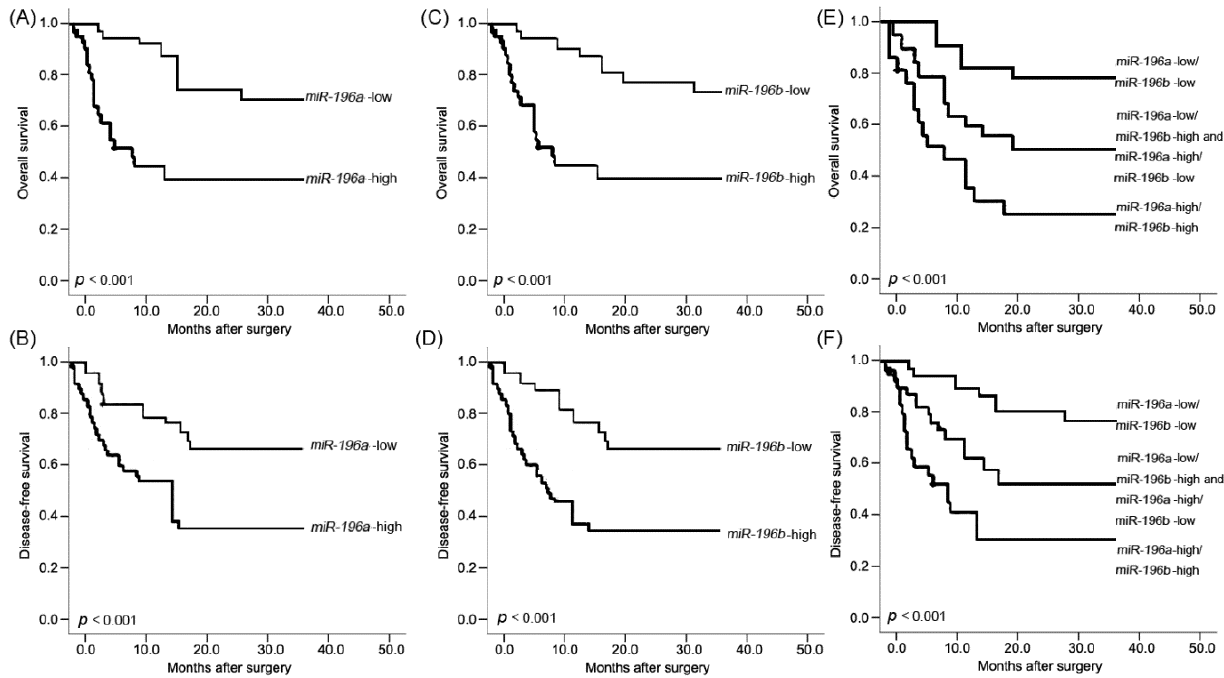
expression (( A ) for overall survival; ( B ) for disease-free survival); miR-196b expression (( C ) for overall survival; ( D ) for disease-free survival) and concomitant miR-196a and miR-196b expression ( miR-196a / miR-196b , ( E ) for overall survival; and ( F ) for disease-free